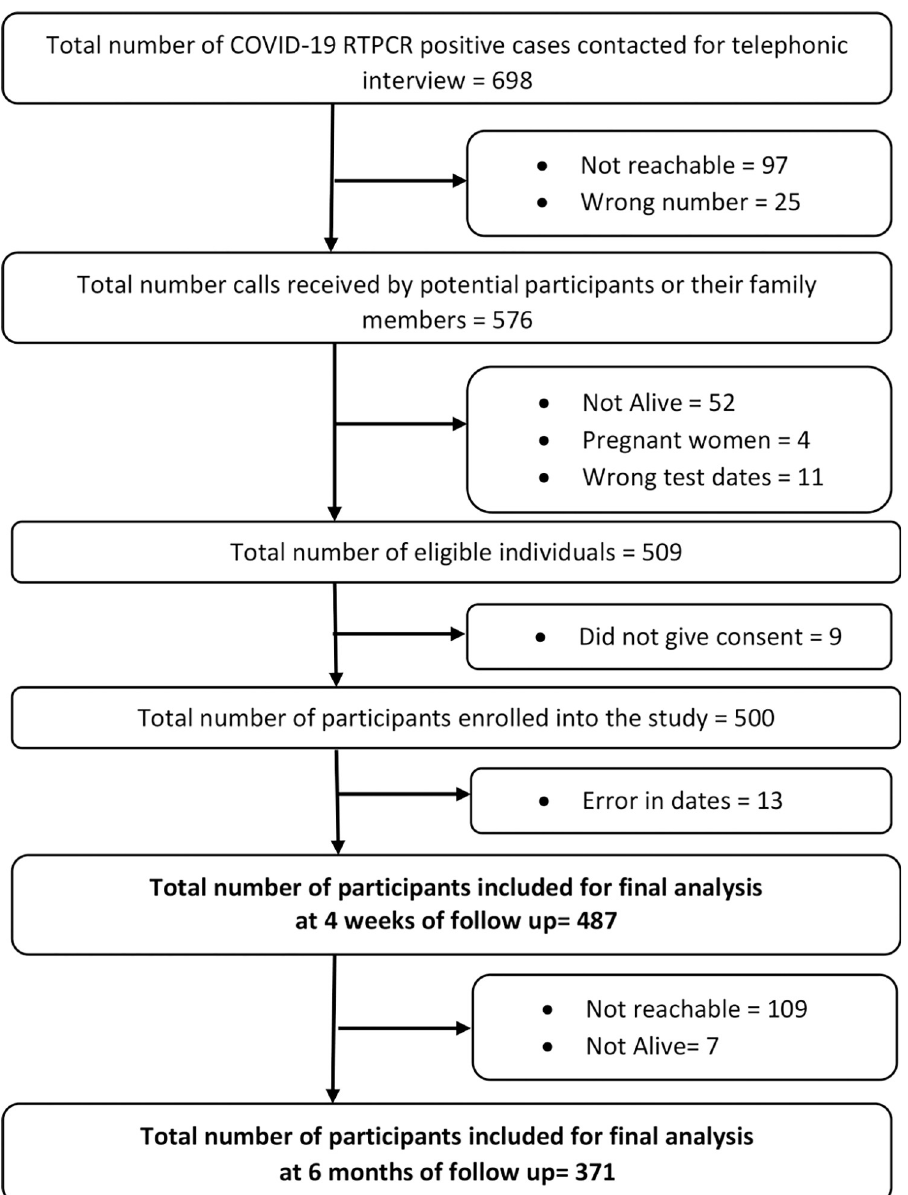
Fig 1. Flow chart showing the selection of study participants and follow-up at four weeks and six